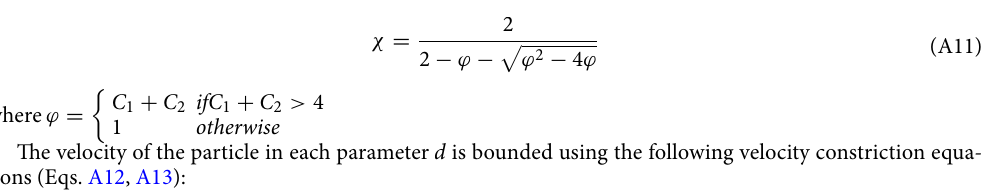
parameters, r 1 and r 2 are random numbers between 0 and 1, current position at generation G , respectively, from the Pareto archive. 4. Divide swarm into three parts to employ distinct mutation treatments: no mutation, uniform mutation, and non-uniform mutation. 5. The particles are evaluated. The personal best position ( x best ) for each particle is updated by comparing the current and personal best fitness. 6. Update leader set in archive by including non-dominated Pareto solutions and removing dominated solu-